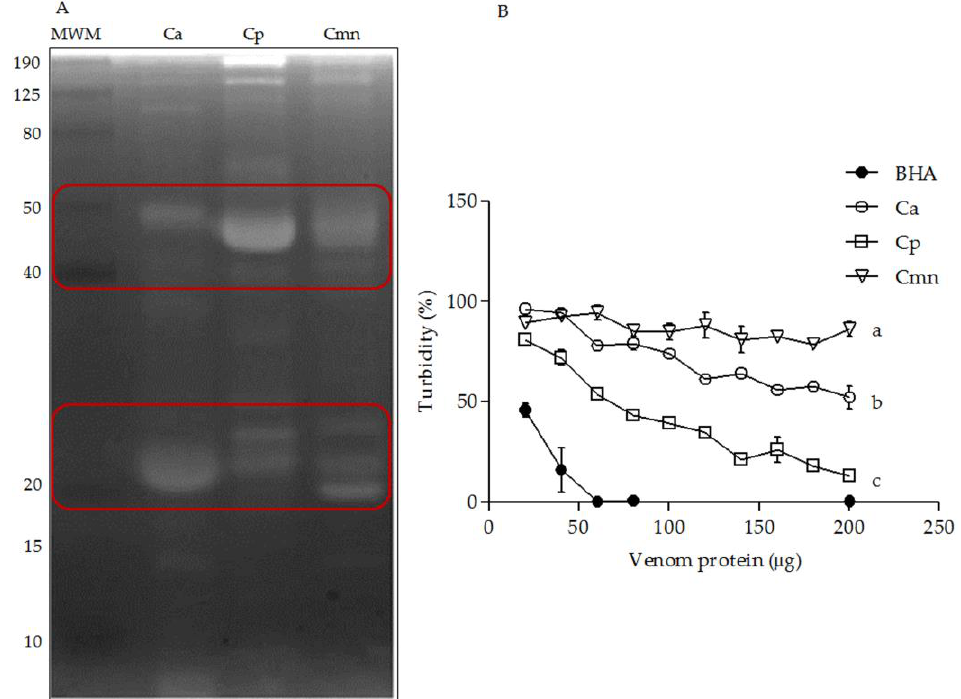
Figure 7. Hyaluronidase activity. ( A ) Zymography on SDS-PAGE co-polymerized with hyaluronic acid using 100 μg venom protein, incubated after electrophoresis for 2.5 h at 37 °C. Molecular weight markers (MWM) in kDa. ( B ) Enzymatic activity using 5 to 50 μg of C. aquilus (Ca), C. polystictus (Cp), and C. molossus nigrescens (Cmn) venoms as well as hyaluronidase from bovine testes used as positive control (BHA). Red boxes show variability between the venoms. Small letters show statistical differences (Tukey p < 0.05) between samples, positive control was not compared.